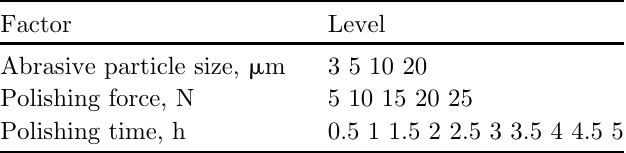
Table 4. Single factor experiment of inhead type of magnetorheological